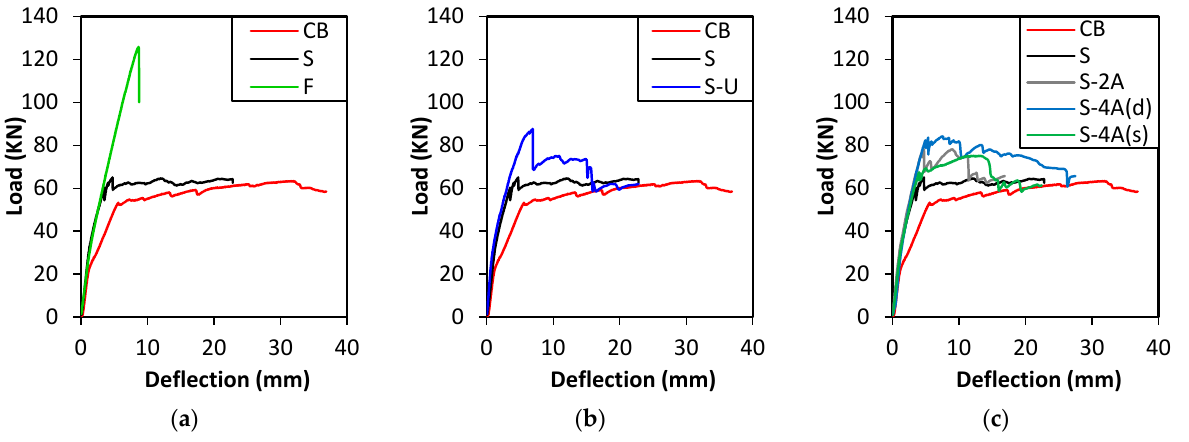
Figure 5. Load-deflection curves for specimens: ( a ) CB, S, F; ( b ) CB, S, S-U; ( c ) CB, S, S-2A, S-4A.